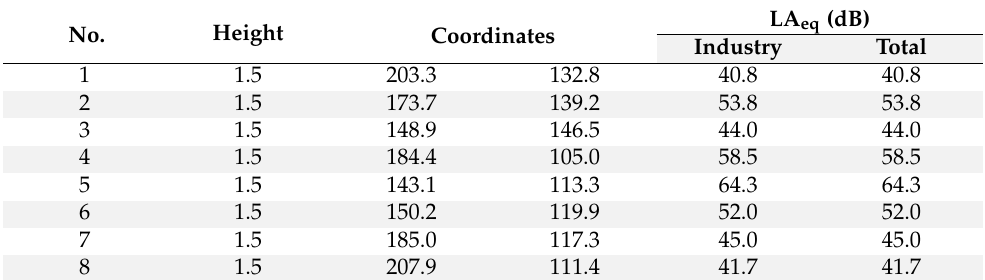
Figure 18. Colour map of isophone bands after considering acoustically significant elements with construction site fencing and a solid gate for superstructure construction in the investigated area, with the position of machines inside the construction site. Table 22. Table of points from the calculation of measured points for superstructure construction with construction site fencing and a solid gate in the investigated area, with the positions of machines inside the construction site.